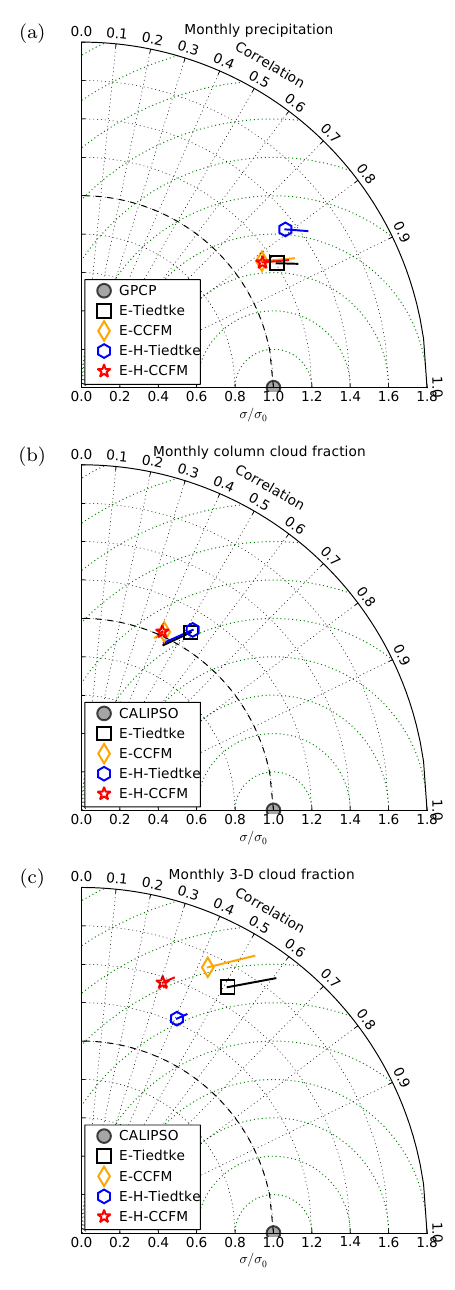
Figure 7. Taylor diagrams comparing (a) monthly mean precipi- tation, (b) COSP-simulated column cloud fraction and (c) COSP- simulated 3-D cloud fraction (bottom) between 30-year AMIP- type simulations using ECHAM(–HAM) with Tiedtke–Nordeng and CCFM (L − 2) convection, and the Global Precipitation Clima- tology Project (GPCP) and CALIPSO–GOCCP respectively. The line segments extending from each point indicate the normalised mean bias, as suggested in Taylor